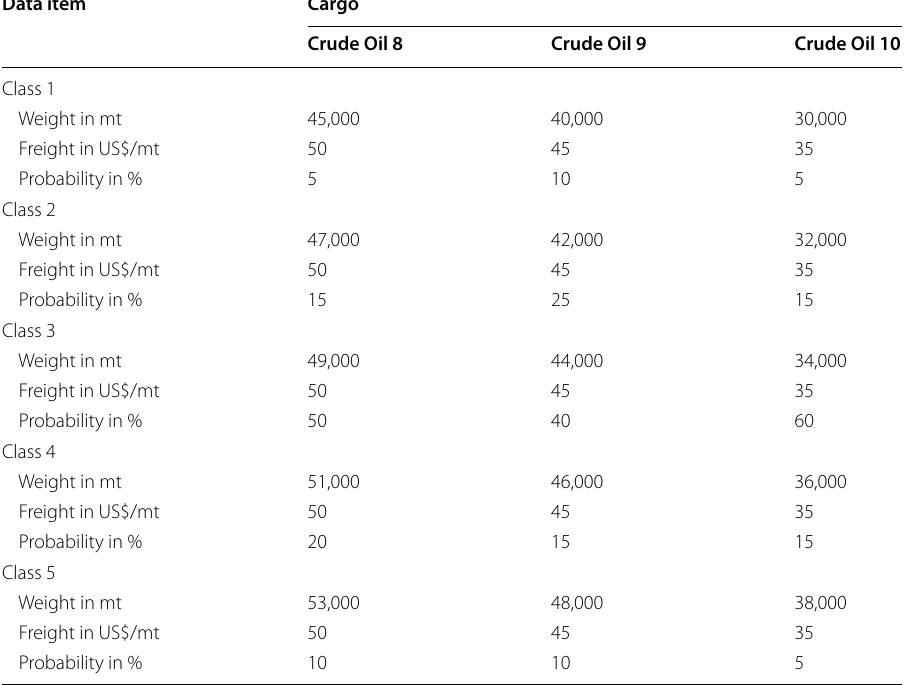
Table 4 Unconfirmed cargo additional quantity data